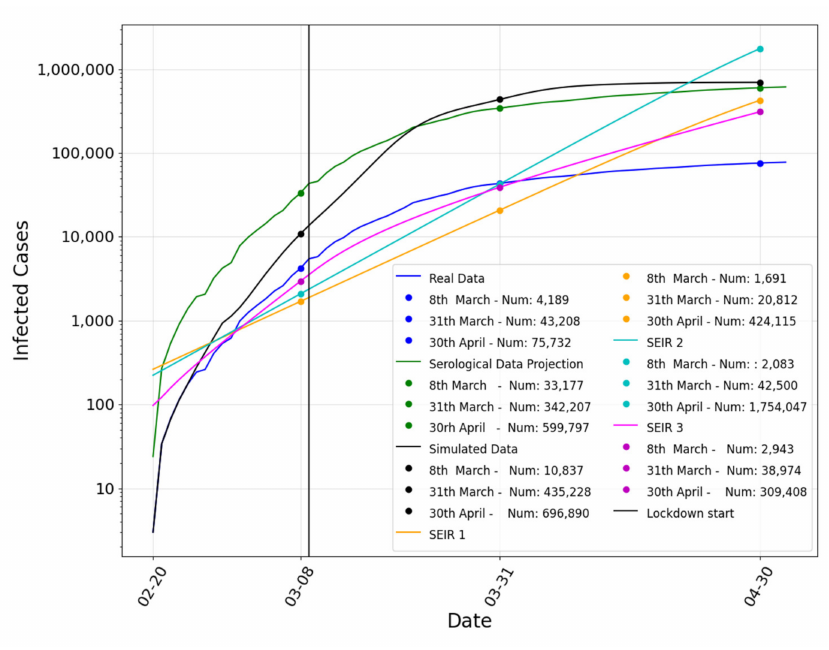
Figure 16. Comparison among our model, the serological data, the real data and the SEIR models (incremental representation—y-axis scale is logarithmic). Table 3. Comparison of our model to the SEIR models in terms of root mean squared error (RMSE) and the Pearson